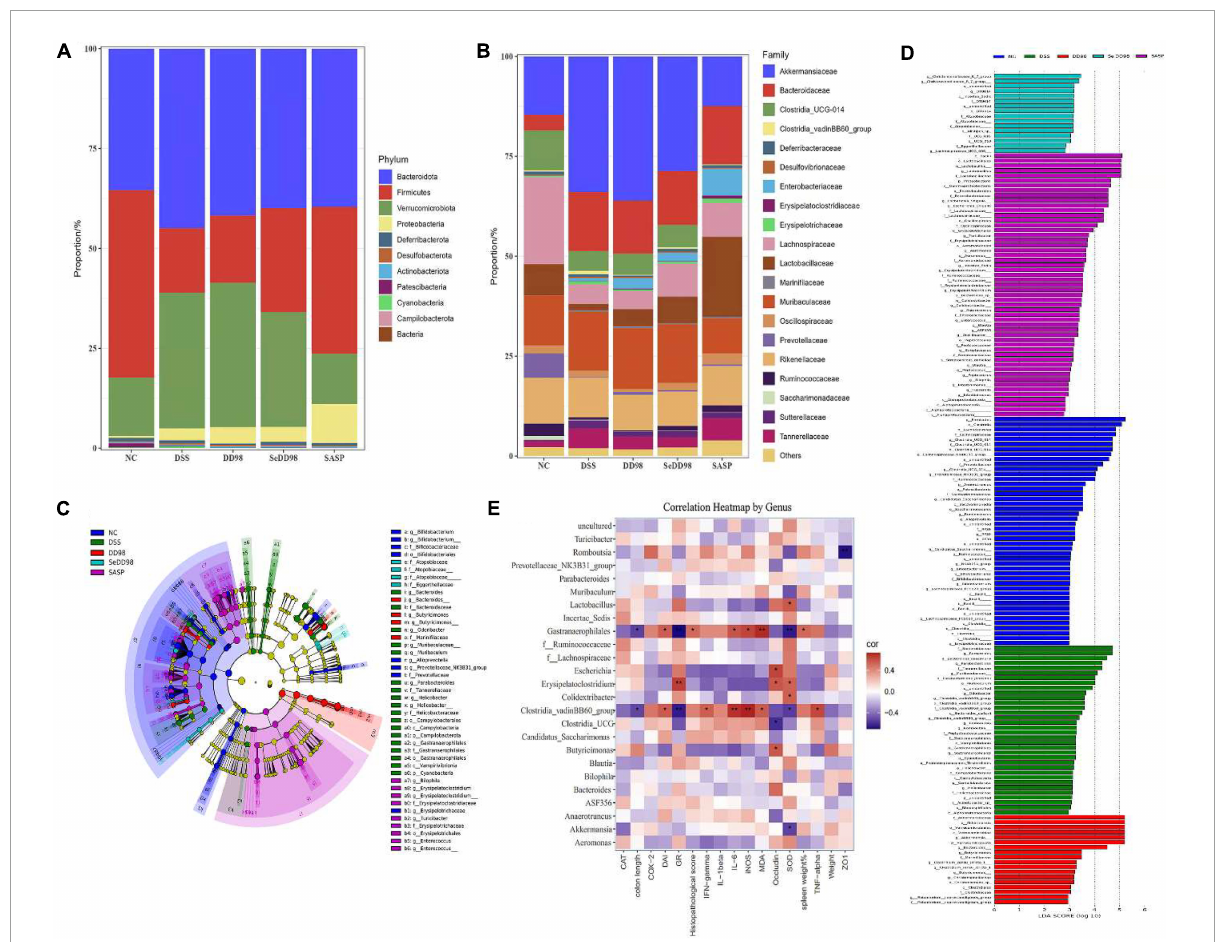
FIGURE7 Relative abundance of taxa at the phylum (A) and family (B) levels; Cladogram of LEfSe analysis (C) and Histogram of the LDA scores (D) ; Correlation between gut microbiota and colitis parameters by Spearman correlation analysis. ∗ Spearman’s correlation is significant at a level of 0.05; ∗∗ Spearman’s correlation is significant at a level of 0.01 (E) ( n =